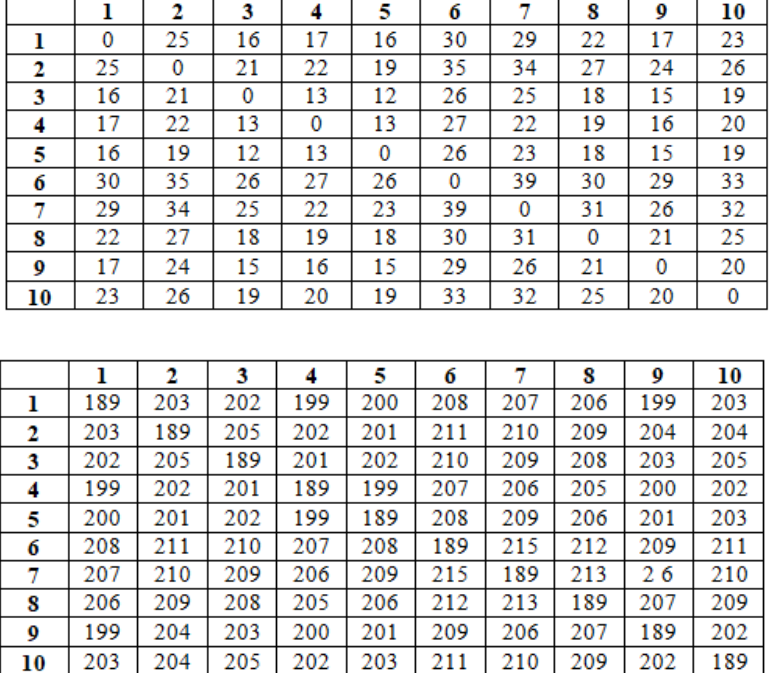
Figure 11. Distances between pairs of templates of the same device ( top ) and two different devices ( bottom ).